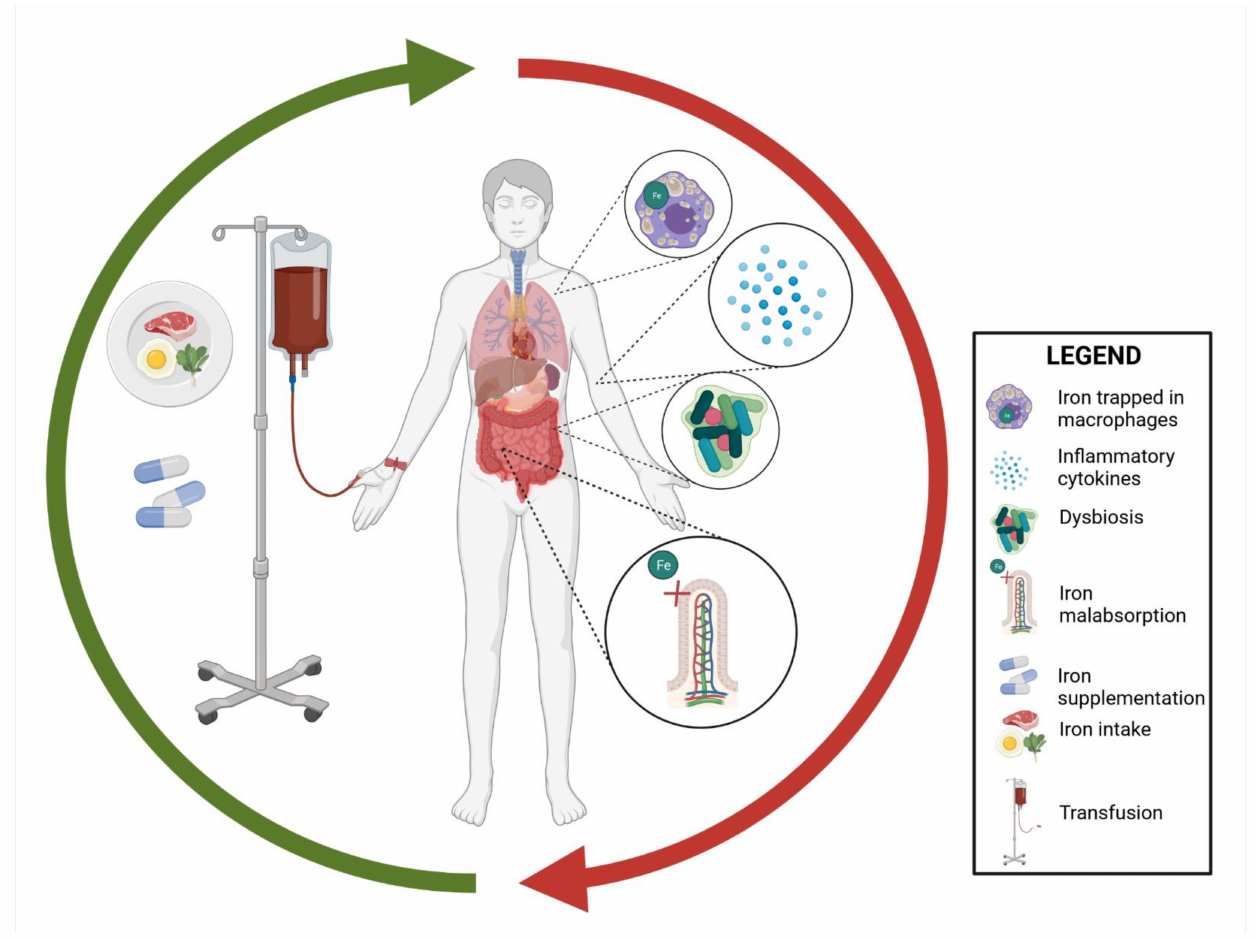
Figure 1. The effect of inflammation in IBD (inflammatory bowel disease) is mainly mediated by hepcidin [24]. Hepcidin is a peptide hormone produced in the liver. It plays a key role in regulating iron homeostasis. It is a direct inhibitor of ferroportin—a protein that transports iron beyond the cells that store it. The hepcidin–FPN (ferroportin) axis is considered to be the main regulator of iron homeostasis [24]. Inhibited ferroportin, present on enterocytes and macrophages, inhibits the transport of iron from enterocytes to the hepatic portal vein system, thus reducing iron absorption. Inhibited ferroportin leads to an inhibition of iron export, which is mainly found in the intestinal epithelium, macrophages, and hepatocytes. Consequently, the transport of iron absorbed by the intestines into the circulation and the release of iron from other cells is inhibited, which results in lowering the iron content in the serum. The inflammatory reaction significantly affects iron metabolism in the human body. The role of hepcidin explains the relationship between the immune response and iron metabolism